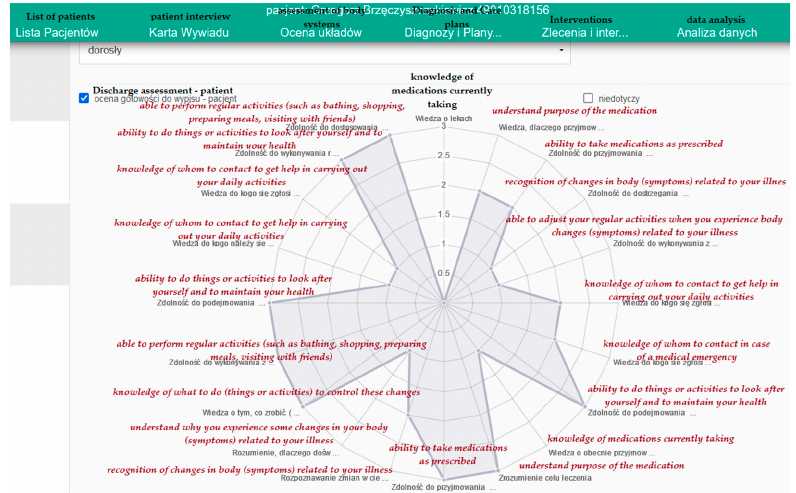
Figure 7. Assessment of the patient’s health competences with the use of C-HOBIC; source: https://pielegniarki.umed.pl/wypis.html (accessed on on 19 April 2022) [52].